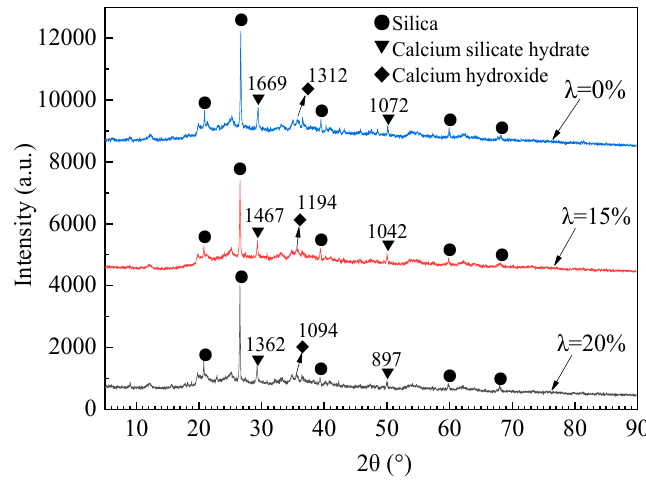
Figure 13. X-ray diffraction spectra of cemented soil samples.